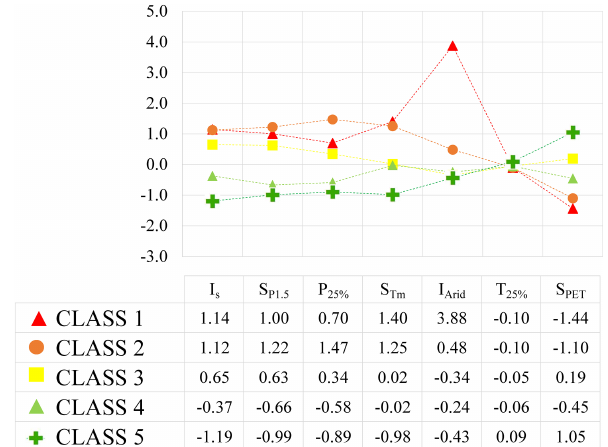
Figure 4. Normalized indices values of the five climatic class kernels from the Mediterranean catchment’s classification using WorldClim-2 data. Table 6. Sample of the decision tree set of rules for the gridded classification (D1–D5 correspond to distance to kernel of classes 1– 5). As an example, for class 1, if the distance to kernel 1 (D1) is below 3.5 and the distance to kernel 2 (D2) is above 2.2, then the grid cell belongs to class